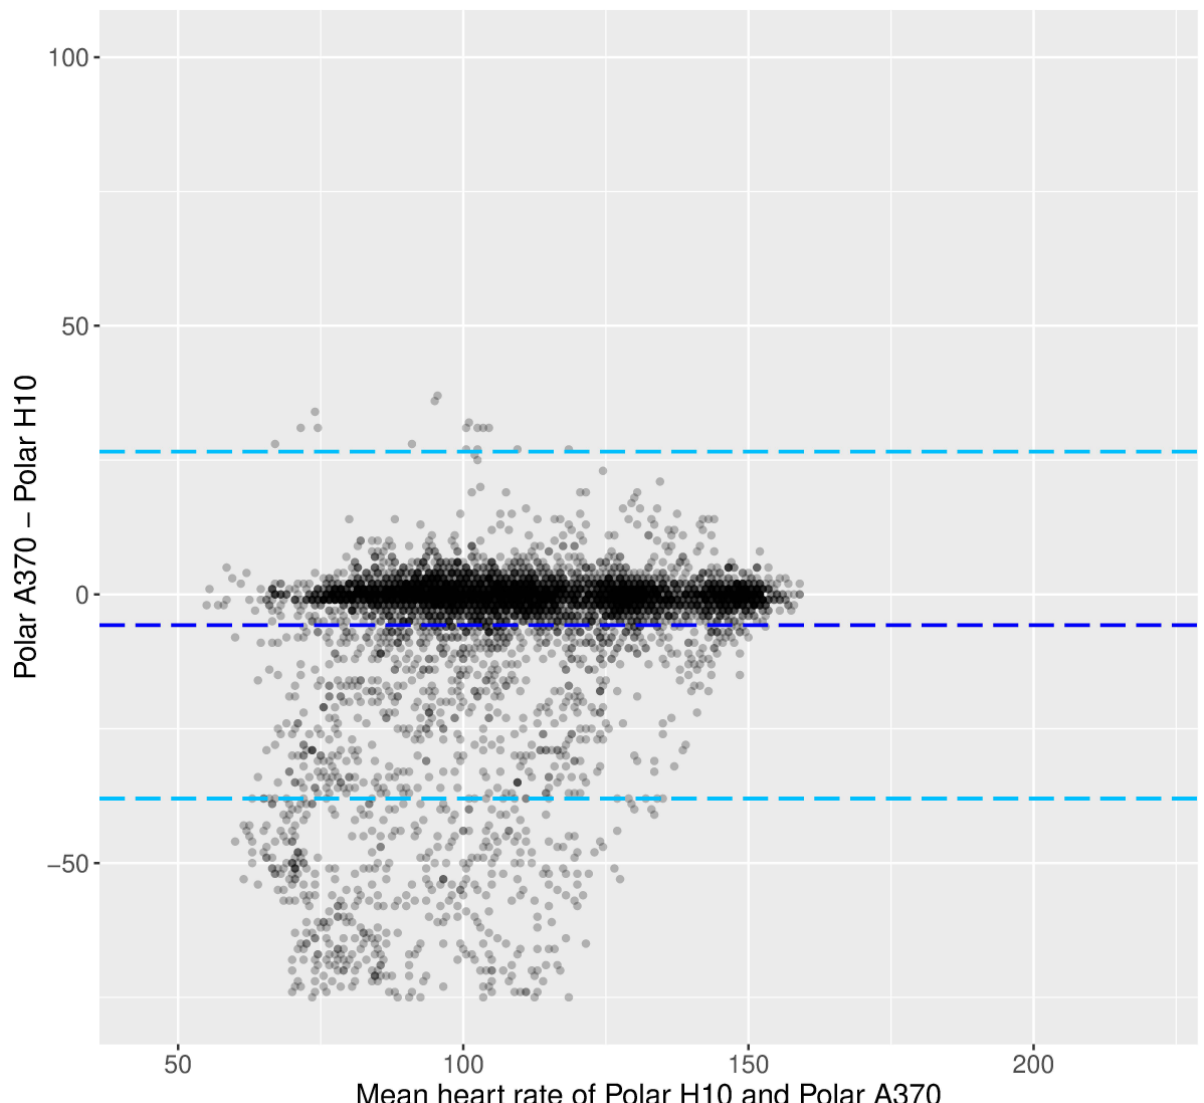
Figure 4. Laboratory phase: Bland-Altman plot between the heart rate data from the Polar H10 and the Polar A370. Light blue dotted lines show the limits of agreement, and the dark blue dotted line shows the mean of the difference. HR: heart